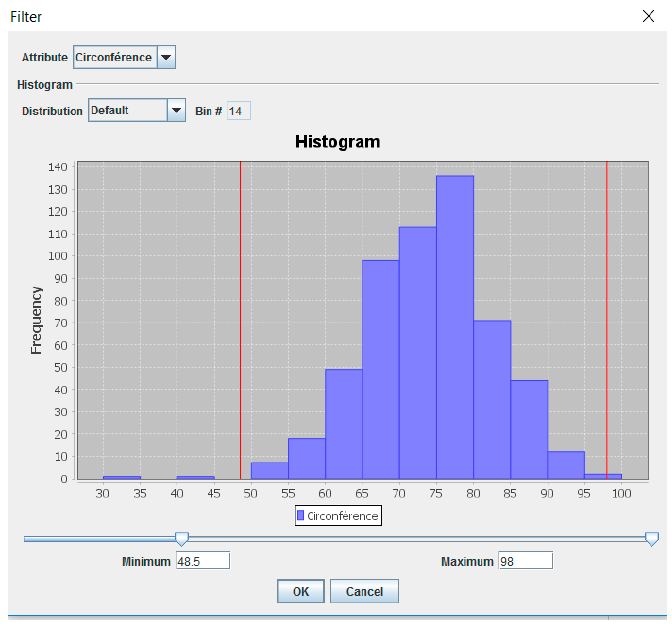
Figure 3. Filtering of the pseudostem circumference values based on distribution of response in the attribute space.